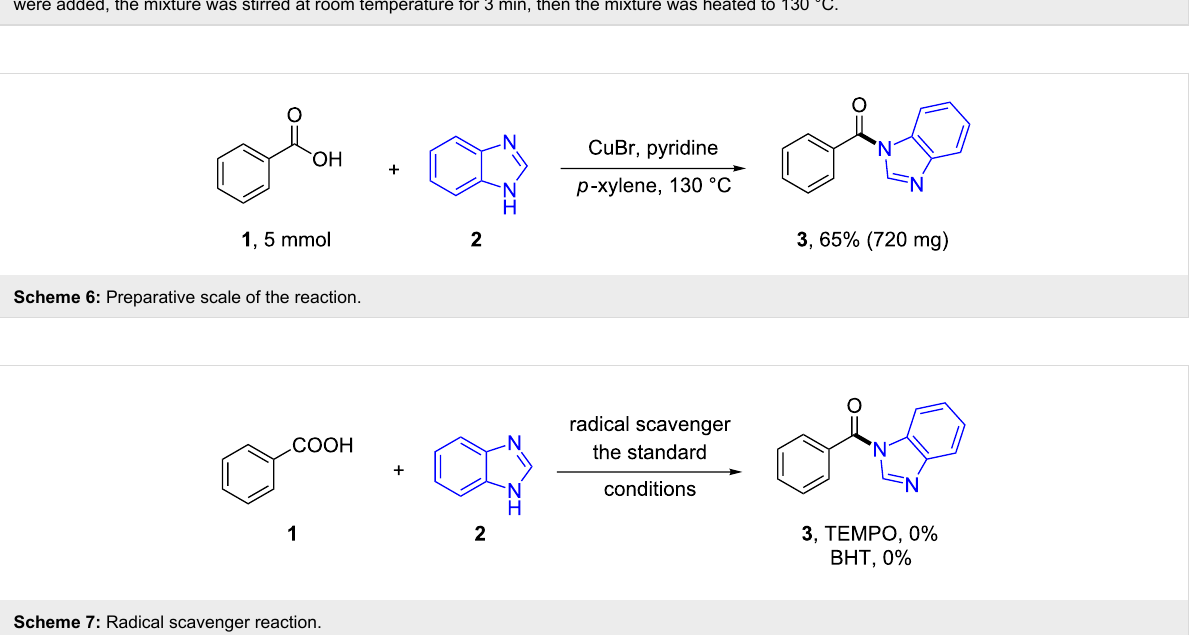
Scheme 5: Scope of the amine transamidation from benzimidazole amides. Reaction conditions: benzimidazole amide (0.25 mmol), amine (0.375 mmol), p -xylene (1 mL), 130 °C, sealed tube. Isolated yields. a Methyl L-leucinate hydrochloride as the ammonia source and Et 3 N (1.5 equiv) were added, the mixture was stirred at room temperature for 3 min, then the mixture was heated to 130 °C.